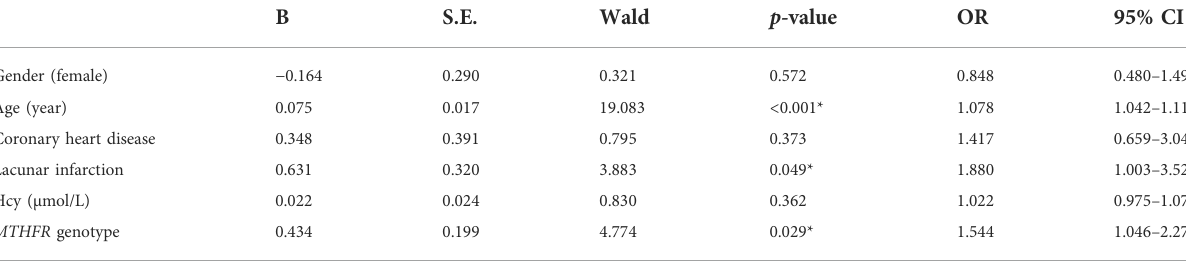
TABLE 4 Multivariate logistic regression analysis of white matter